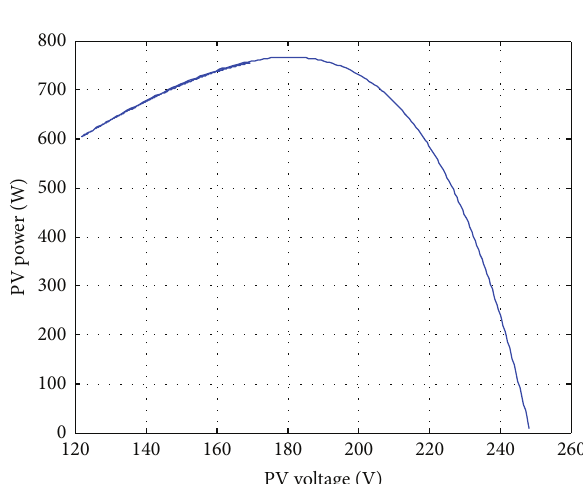
Figure 22: PV power-voltage waveform.